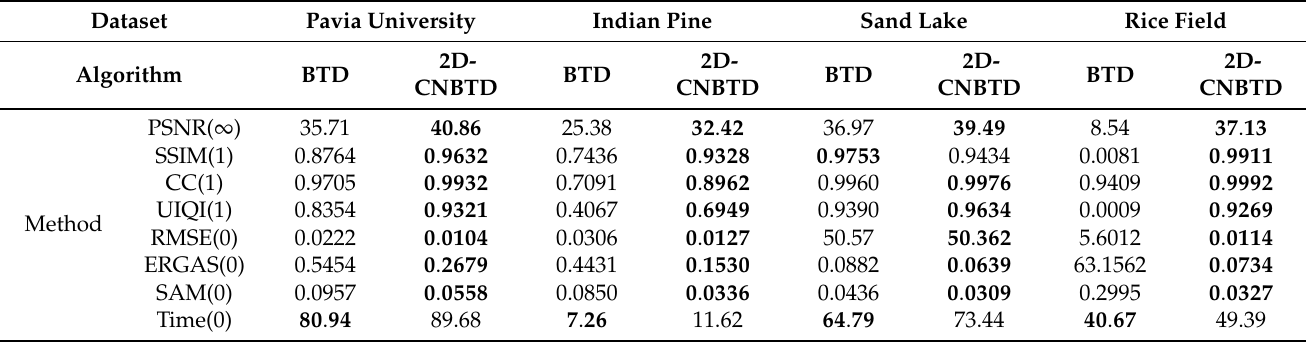
Table 1. Comparison of BTD and 2D-CNBTD